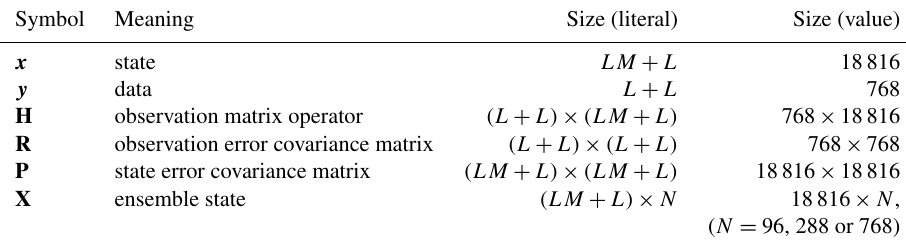
Table 2. Notations and dimensions of data assimilation